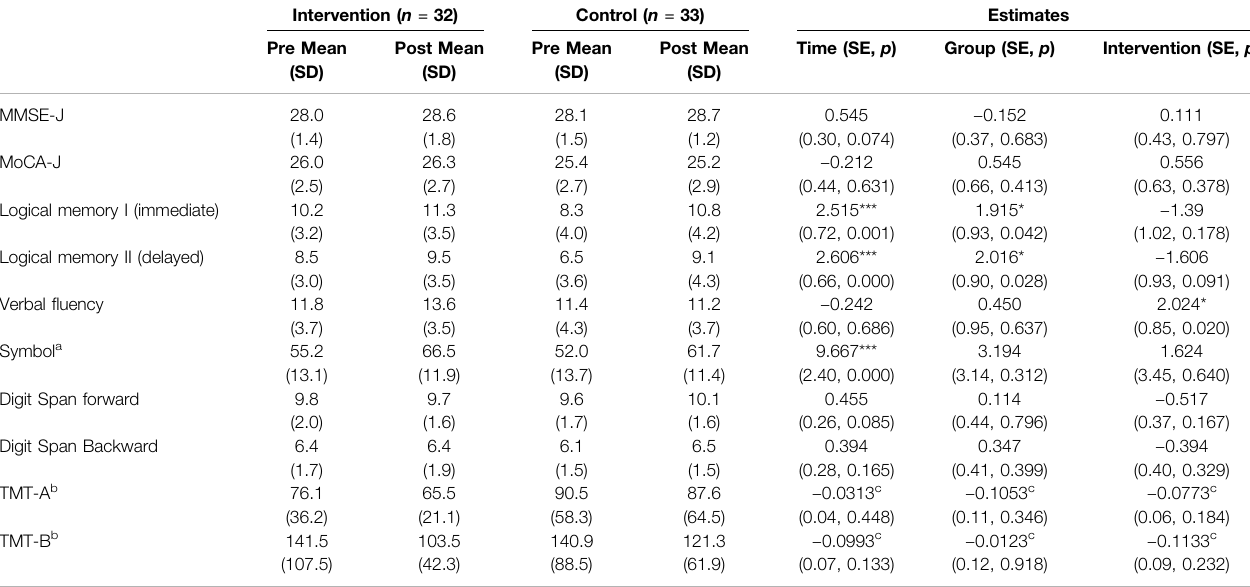
TABLE 4 | Comparison of Pre/Post cognitive test scores in intervention and control groups.